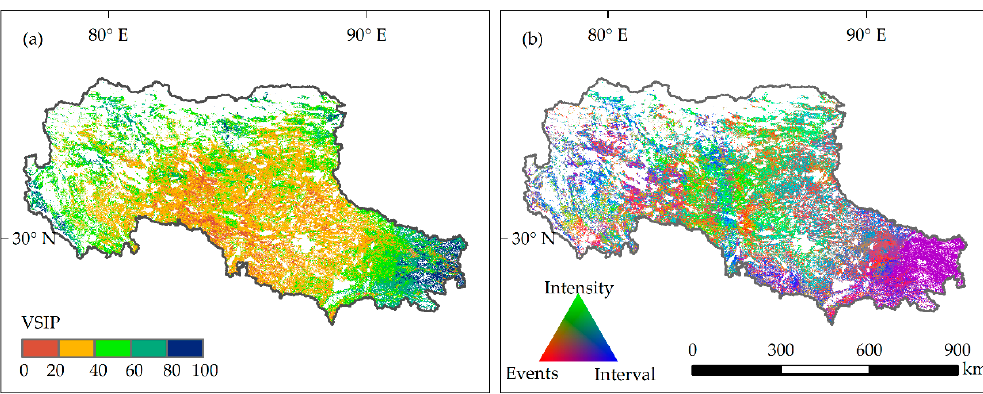
Figure 6. Spatial patterns of ( a ) standardized VSIP and ( b ) relative contribution of the three indicators of precipitation variability to alpine grassland AGB peak : the number of precipitation events (Events), the intensity of precipitation events (Intensity), and the time interval between consecutive precipitation events (Interval). Table 3. Pixel percentage (%) at five different levels of the standardized vegetation sensitive index to precipitation (VSIP) within each alpine grassland type on the northern Tibetan Plateau. Grassland Type